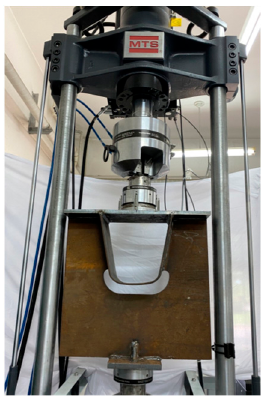
Figure 9. Fatigue loading of specimens.